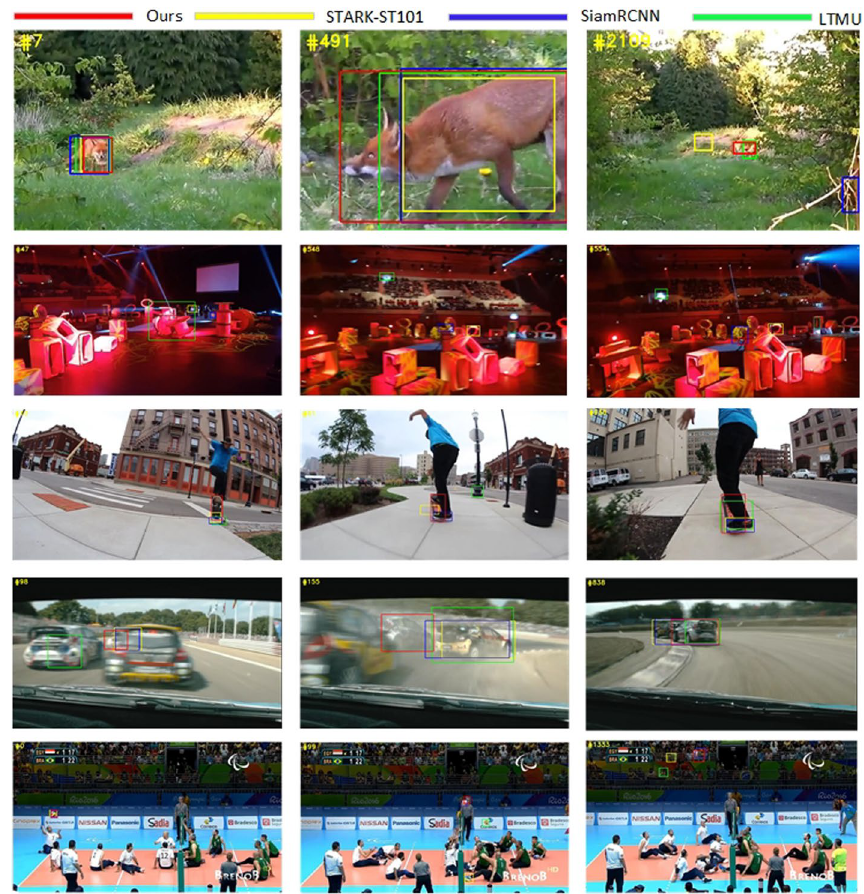
Fig. 8 Qualitative comparison of ours with other state-of-the-art trackers on 5 video sequences from the LaSOT